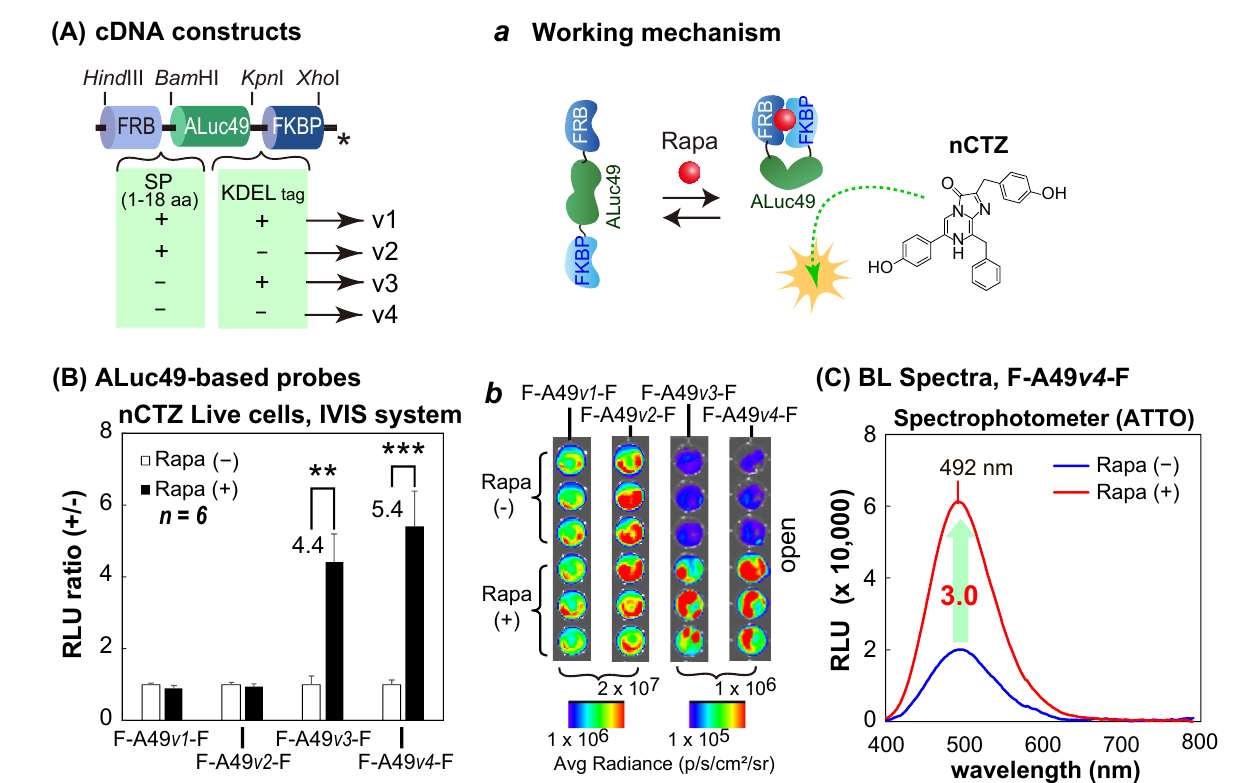
Figure 3. Characterization of the molecular strain probes based on ALuc49. ( A ) The cDNA constructs of ALuc49-based molecular strain probes. The asterisks mean stop codons. The inset a illustrates the working mechanism of F-A49-F in the presence of rapamycin (Rapa). ( B ) Rapamycin-driven optical intensities of the ALuc-based strain probes. The numbers on the bars indicate the fold intensities. The inset b shows the corresponding BL images before and after rapamycin stimulation. The p -values (Student’s t -test) are ** < 0.01 and *** < 0.001. ( C ) The BL spectra of F-A49 v4 -F in the presence or absence of